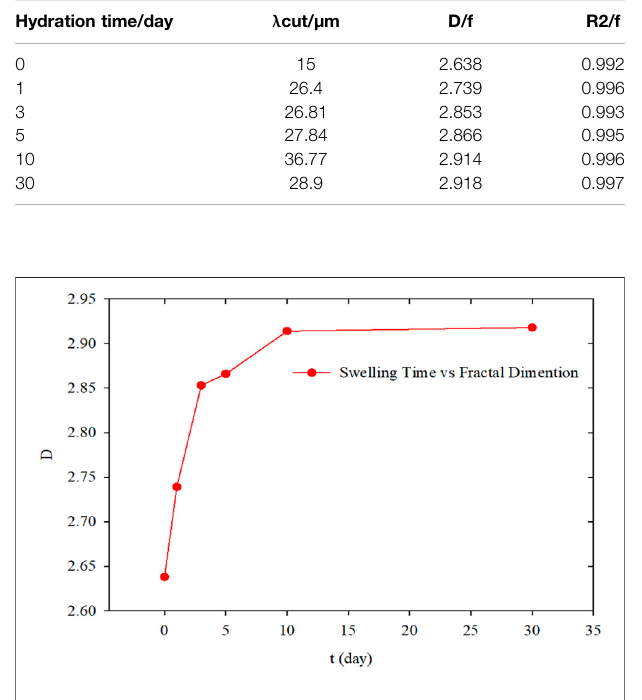
FIGURE 6 | Fractal dimensions calculated with fractal cumulative probability method versus hydration time.